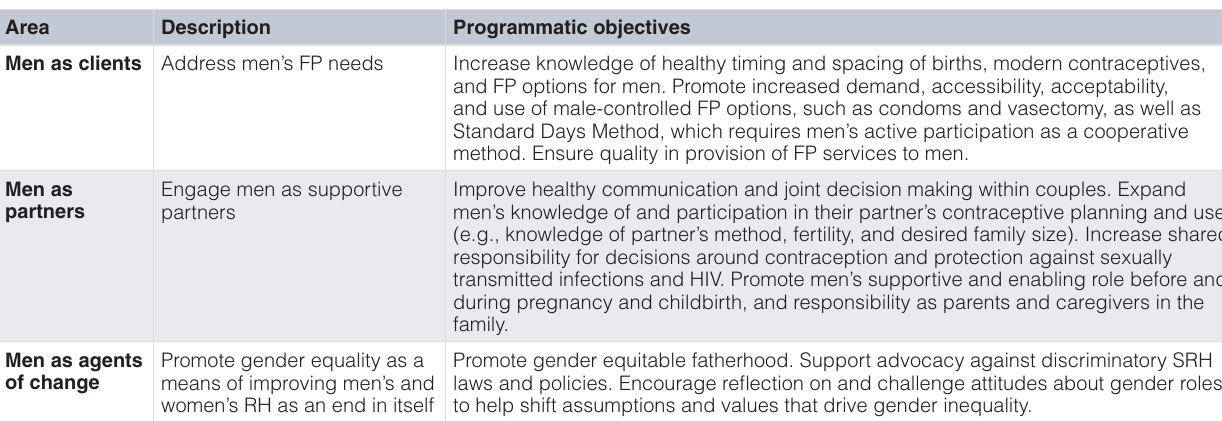
Table 2. Programmatic areas, descriptions, and objectives in the Constructive Male Engagement Framework.